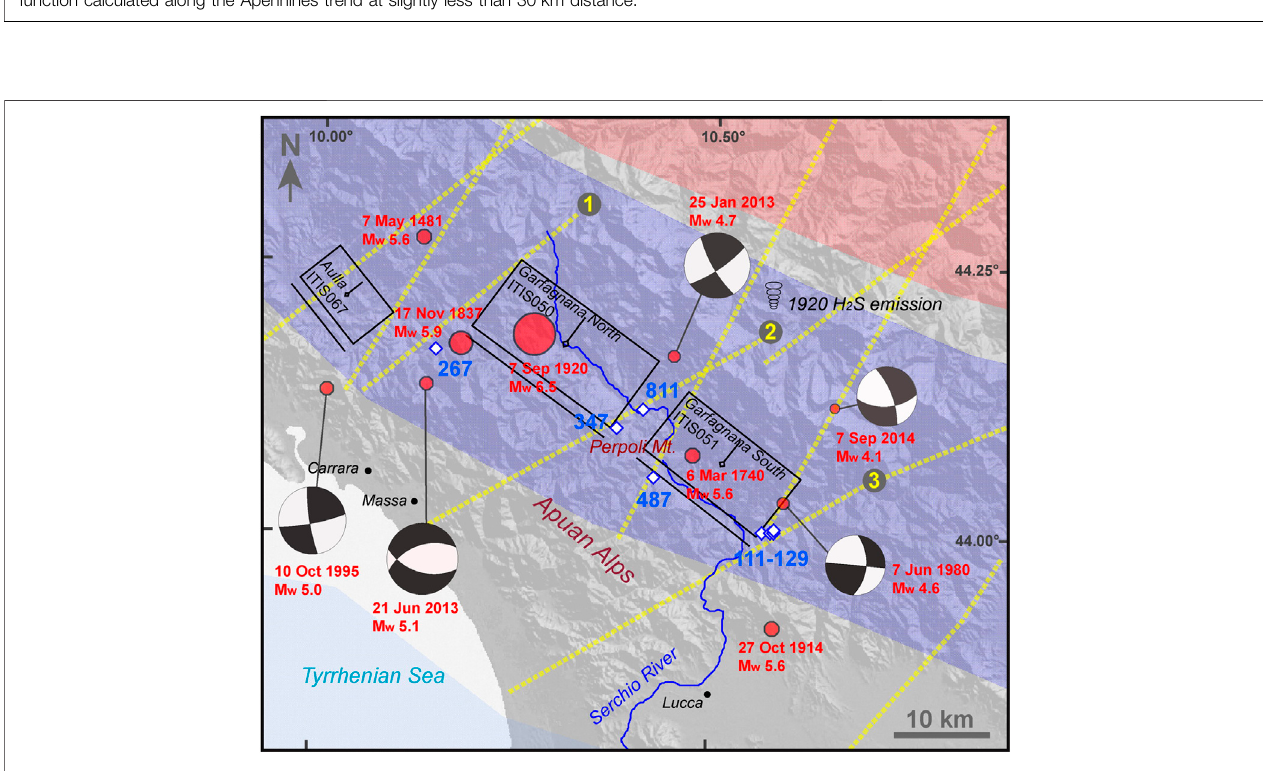
FIGURE10| Seismogenicfaults,transverselineamentsandthermalspringsintheGarfagnanaarea,northernTuscany(see Figure4 forlocation).Theblackboxes are the surface projections of Individual Seismogenic Sources from the DISS database: source ITIS050 is assumed to have caused the September 9, 1920, M w 6.5 earthquake,whilesourceITIS051 isassumedtobequiescentandcapable ofgeneratingaM w 6.1earthquake.Thetransverselineamentsareshownwithyellowdashed lines and identi fi ed by a number (see text). The springs are shown by diamonds and are labeled with their ID from the Database of Thermal Springs . The 3D spiral symbol locates a H 2 S emission that was activated following the 1920 earthquake (Casoni site, from CFTI5Med; see Earthquake-Induced Geo fl uid Emissions Section). Notice that the most recent earthquakes fall near the edges of the largest seismogenic normal faults, that their faulting mechanism is consistently strike-slip.